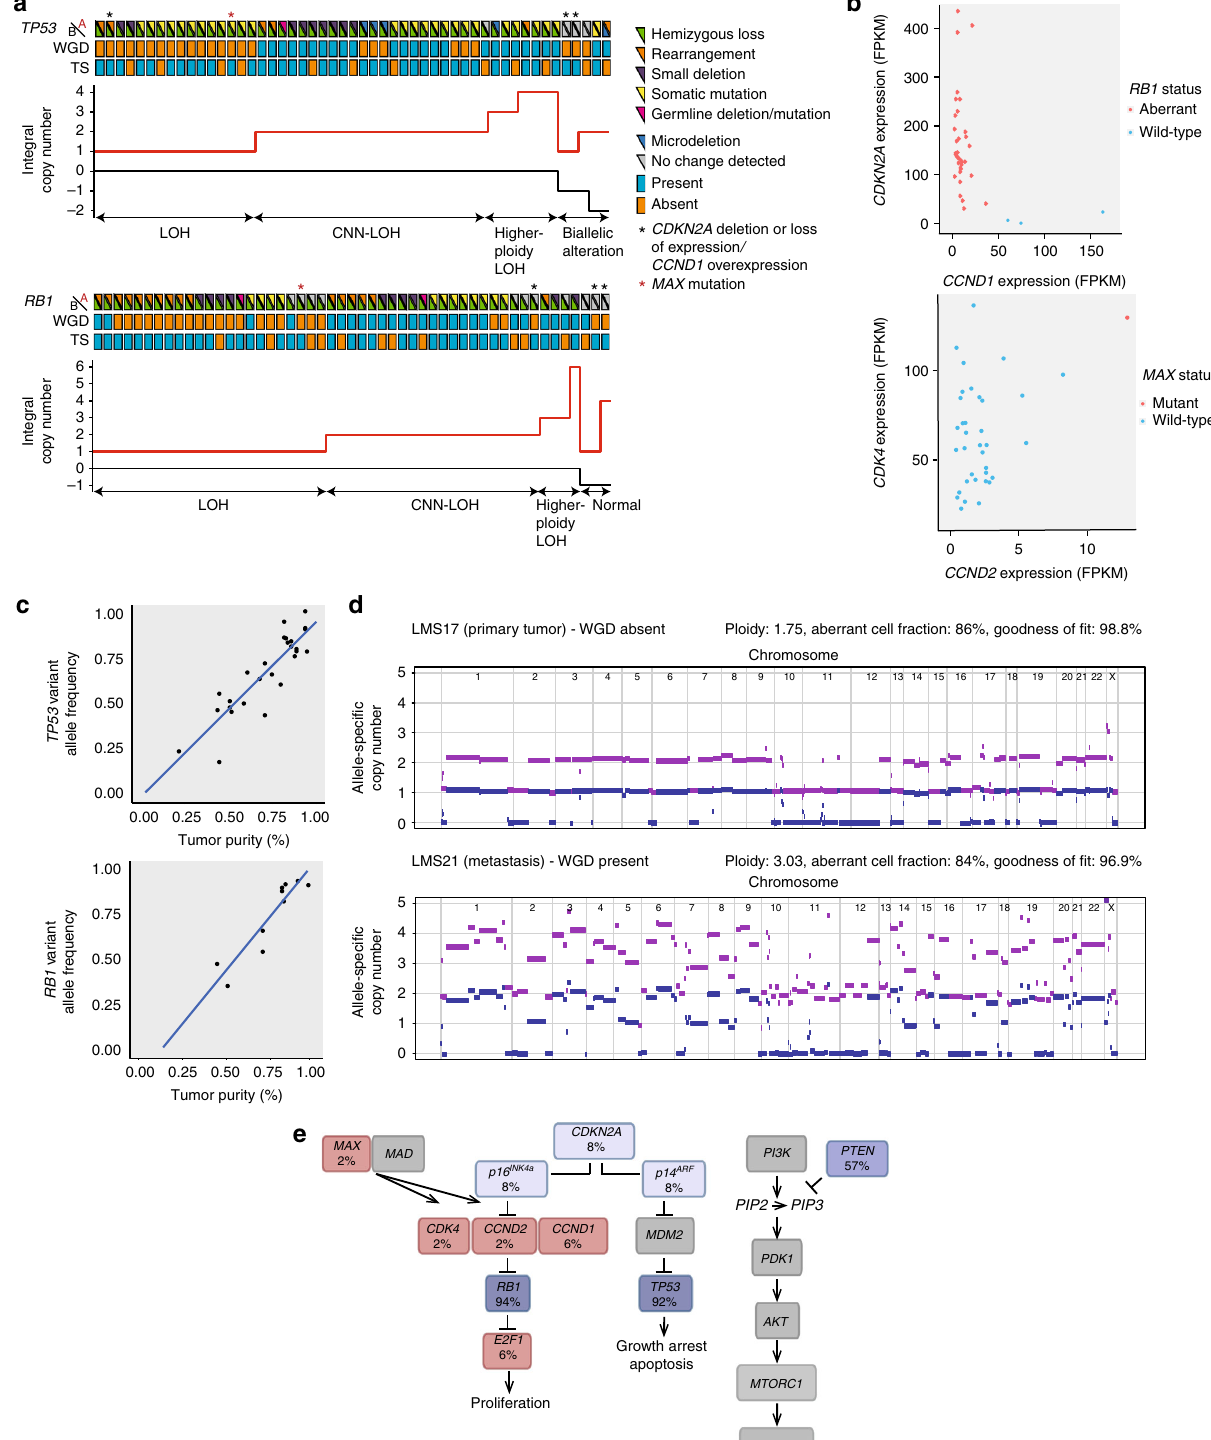
Ploidy: 1.75, aberrant cell fraction: 86%, goodness of fit: 98.8%